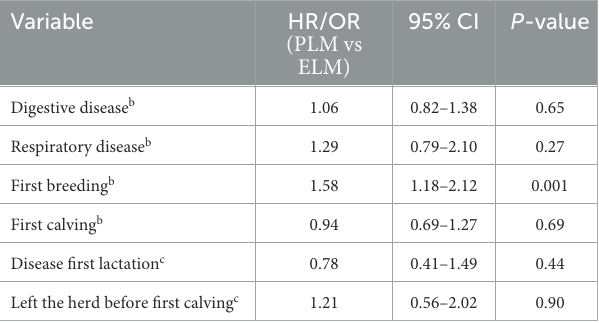
TABLE 2 Comparison of health, reproductive, and survival outcomes organized by statistical analysis using an adjusted model a